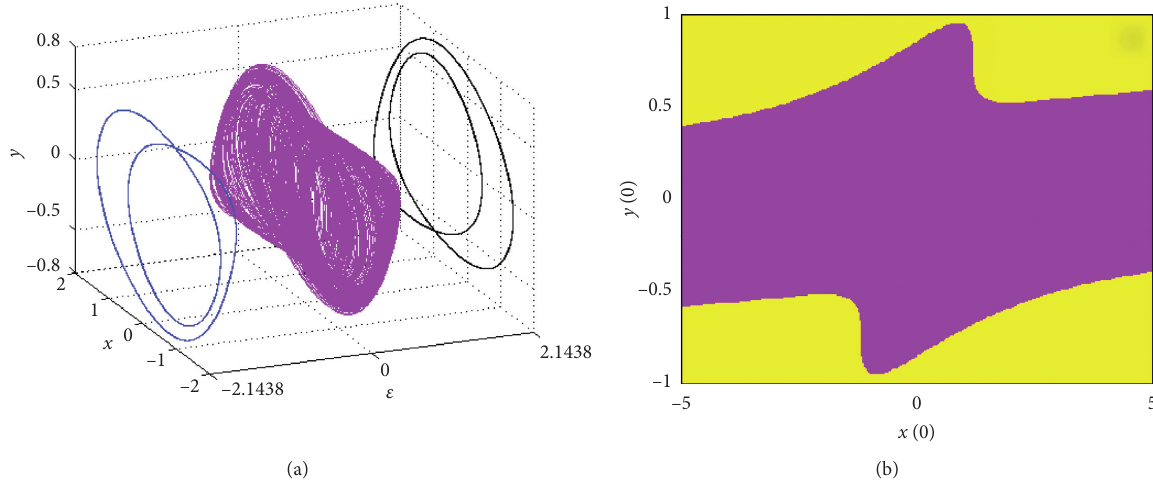
Figure 9: (a)Three-dimensionalprojections ofthesurviving stablestatesin theplane ( ε , x, y ) forthetypical valueofthecoupling δ � 0 . 5 for three and S .(b) Crosssections ofthe basinofattraction for z ( 0 ) � 0, corresponding to thedomain distinctvalues ofthe equilibriumpoints,namely, S 0 1 , 2 of initial conditions which enable to obtain each attractor of Figure 9(a) in magenta color. Yellow regions correspond to unbounded